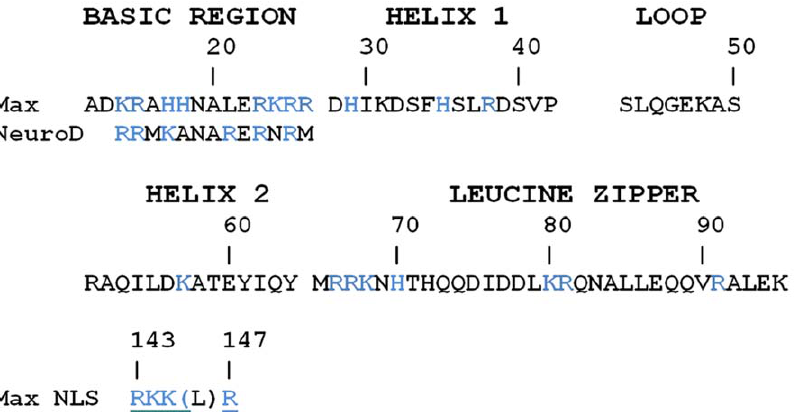
Figure 1. The b-HLH-LZ of Max has a putative NLS sequence and PTD in its basic region. Primary structure of the b-HLH-LZ of Max (Max*). Also shown is the domain of NeuroD responsible for its transduction and nuclear localization and the Max NLS. Note the high content in basic side- chains and the similarity between the sequences.